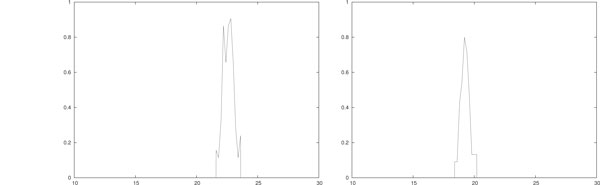
Probability density function, IL-2 mono-therapy. Empirical evaluation of ϱ(ter) for different piece-wise constant (left) and impulsive (right) daily IL-2 immunotherapies. In (left) A = 0.2 and di = 4 · 107/A for i = 1, . . . , 30. In (right) ui = 4 · 107 for i = 1, . . . , 30. In both cases T(0) = 105, E(0) = I(0) = 0 and pE = 20 · 0.1245. All the other parameters are as in Table 3. The densities are obtained by performing 102 simulations for each configuration.